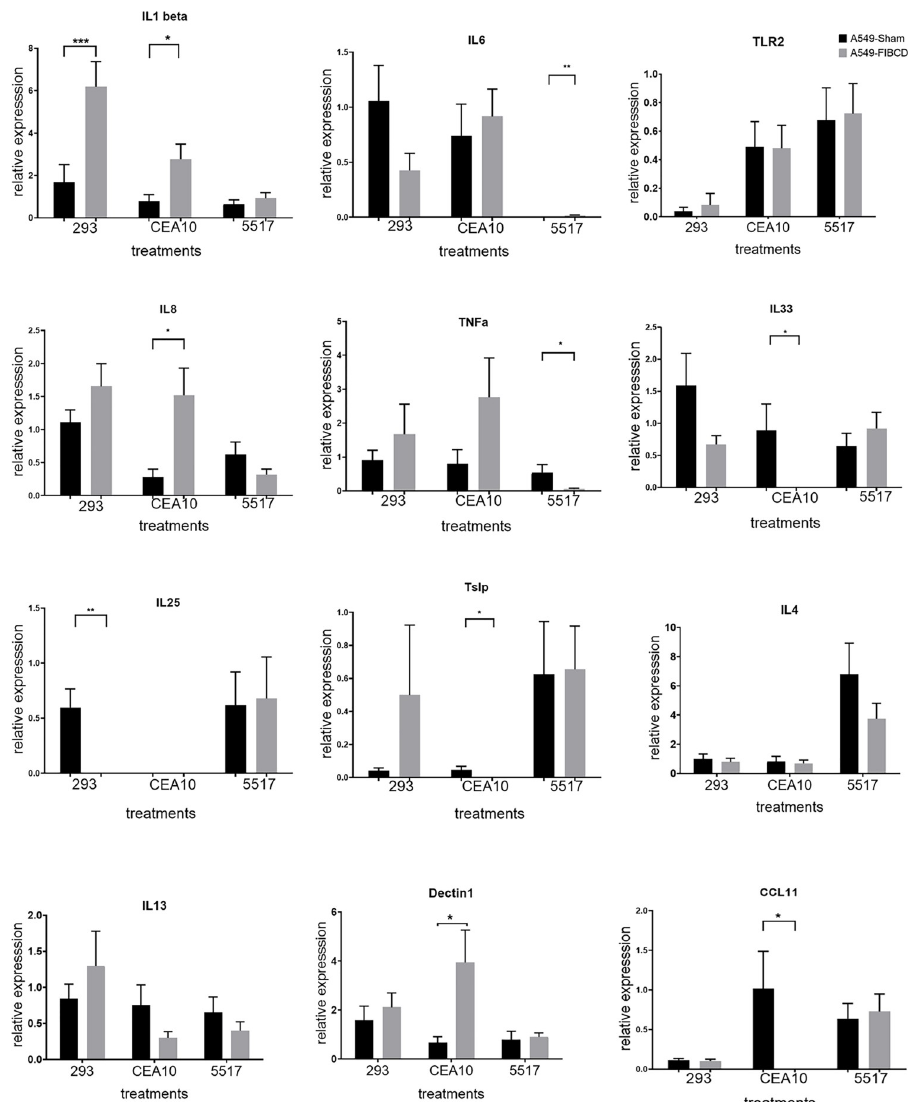
Fig 2. Cytokine modulation in human lung epithelial cells over-expressing FIBCD1 in response to different strains of Aspergillus fumigatus . A549-Sham transfected cells are used as control. Cells stimulated and harvested as described in materials and methods and analyzed by qRT-PCR for expression of indicated cytokines using ΔΔ Ct method. Data are a summary of two-three experiments. n = 12/group. � p < 0.05, �� p < 0.01, ��� p < 0.001, ���� p <